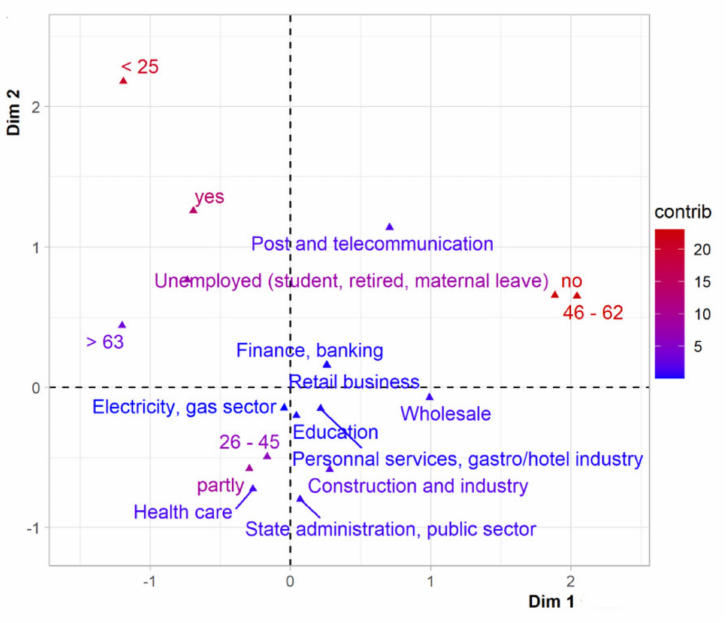
Figure 2. Multiple correspondence analysis factor